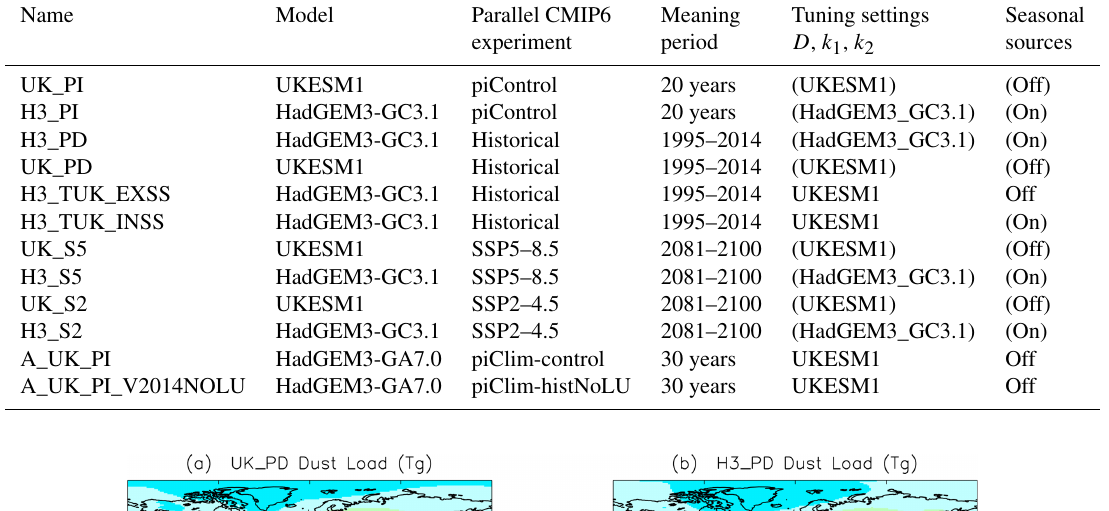
Table 1. Summary of experiments. The UKESM1 tuning settings for D , k 1 and k 2 are 1.0 × 10 − 3 , 1.1 and 0.8 respectively; the HadGEM3 settings are 2.25 × 10 − 4 , 1.45 and 1.1. Tuning settings and seasonal source settings (in parentheses) indicate that the values are the usual ones for the model used in that experiment. For a further explanation of these terms, see Sect. 3.